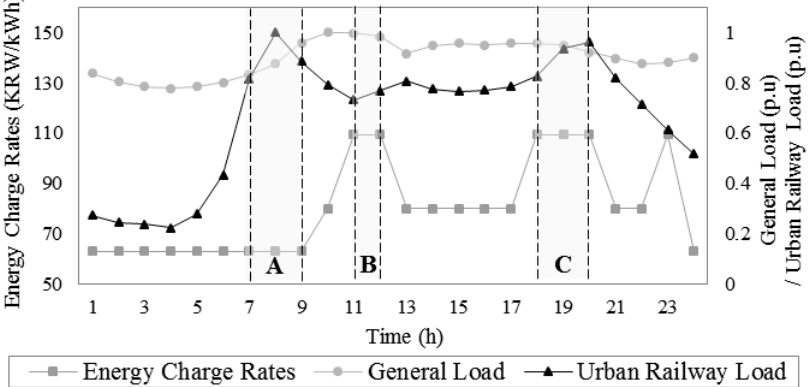
Figure 2. Impact of Load shift on power systems according to relations between urban railway loads and energy charge rates